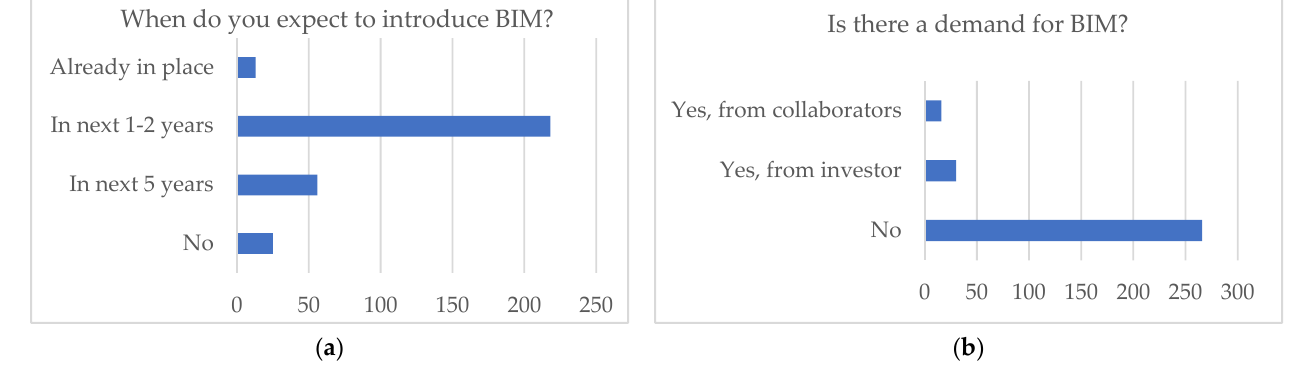
Figure 5. Attitude toward using BIM. ( a ) The intention to use BIM in the near future; ( b ) the existence of request for BIM.